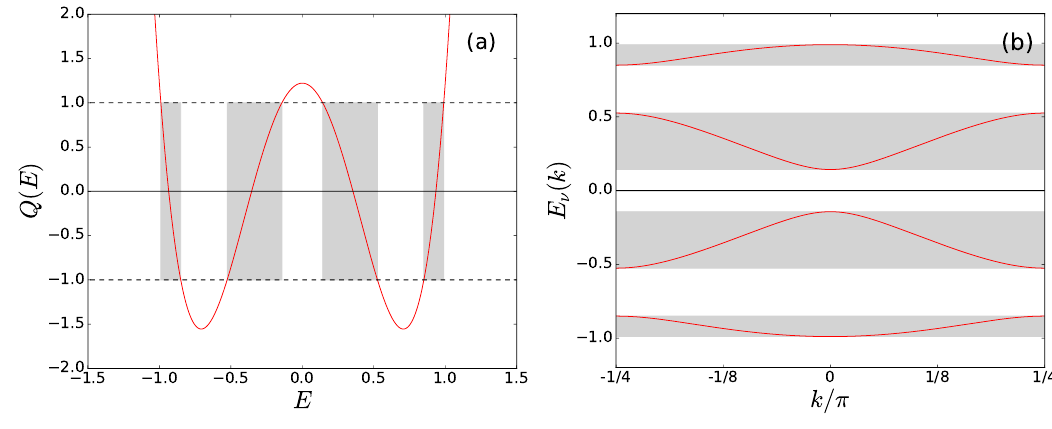
Figure 3: (a) Example of the polynomial Q ( E ) [ Eq. (21) ] for a periodic problem with N = 4 in the Volterra case. (b) Corresponding generic band structure, E ν ( k ) , solution of Eq. (20). The bands are entirely determined by the three parameters I the E → − E symmetry of the